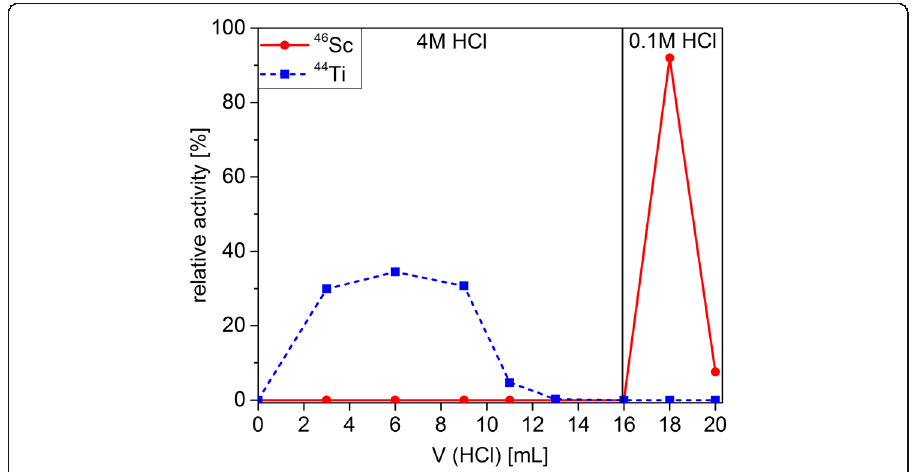
Fig. 3 Elution profile of 44 Ti/ nat. Ti (blue squares) and 46 Sc (red dots) on DGA extraction chromatographic resin. Each fraction was measured by γ -spectroscopy until the statistical measurement error was <5%